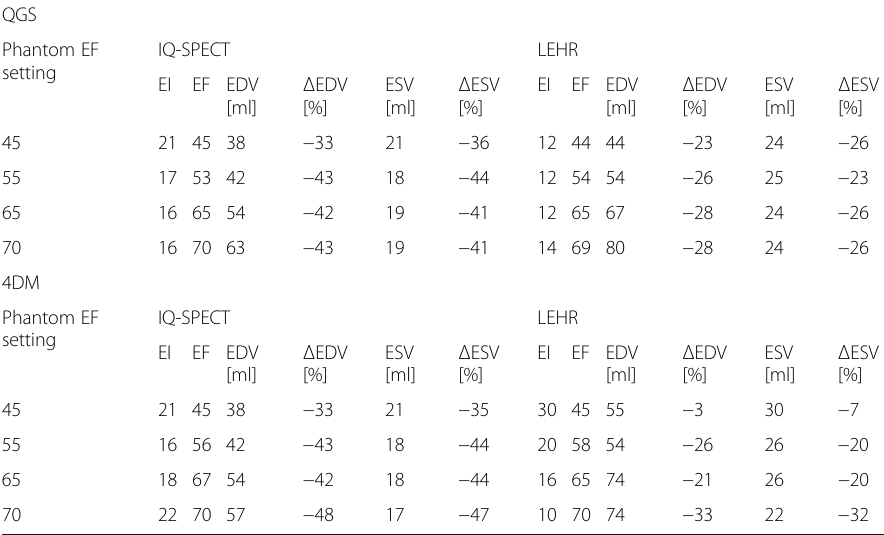
Table 2 The best EF estimates of IQ-SPECT and LEHR imaging protocols and corresponding EI, EDV and ESV values analysed using QGS and 4DM software QGS